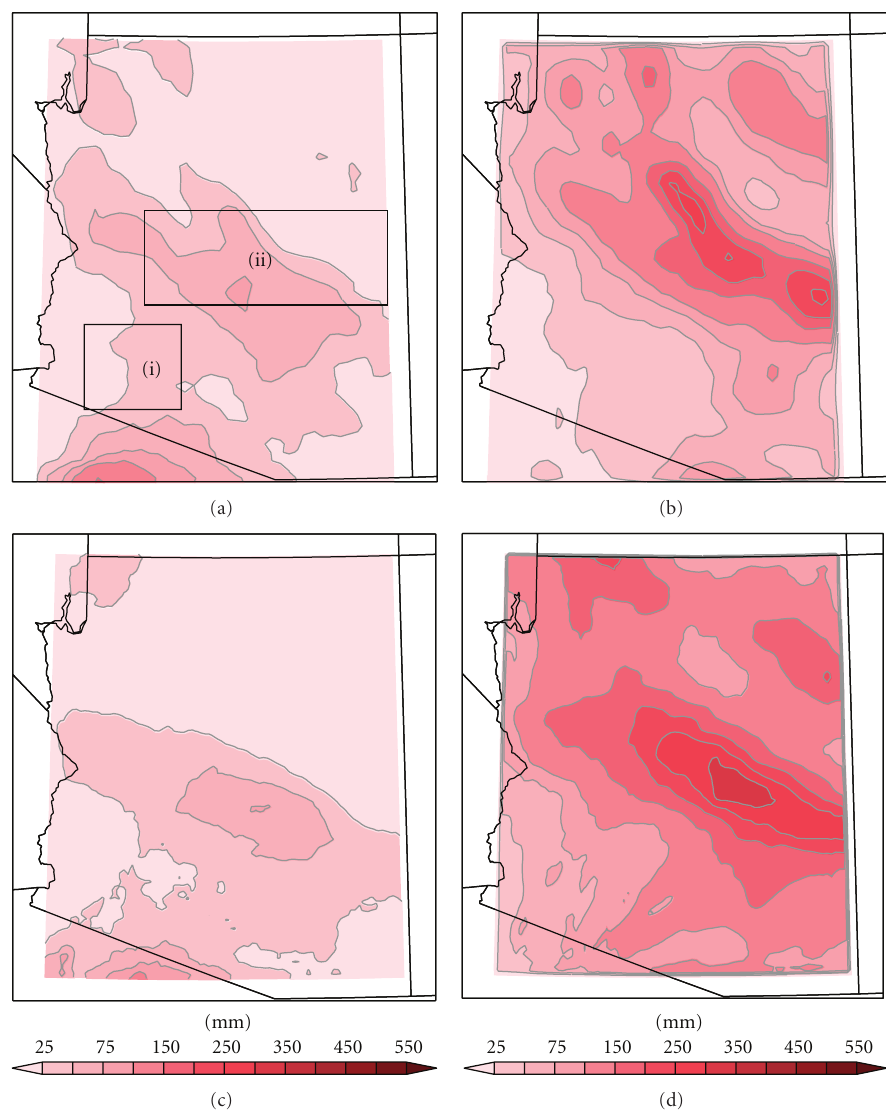
Figure 2: The cumulative rainfall for winter season (November 1–January 31), averaged over 7 winters from 2003 to 2009, from di ff erent sets of runs. (a) Rainfall produced by subgrid-scale cumulus parameterization (RAINC) from the 12km runs. (b) Rainfall produced by grid-scale convection (RAINNC) from the 12 km runs. (c) RAINC from the 6 km runs with cumulus parameterization turned on (d) RAINNC from the 6km runs with cumulus parameterization turned on. Boxes (i) and (ii) in (a) are the areas chosen for the further analysis of the time- series of rainfall in Figures 5–7. Box (i) is defined as 111.78 ◦ W–113.61 ◦ W and 31.90 ◦ N–33.69 ◦ N and box (ii) is defined as 109.35–112.02 ◦ W and 33.25 ◦ N–35.18 ◦ N. The plot shows the whole innermost domain, including the sponge layer for